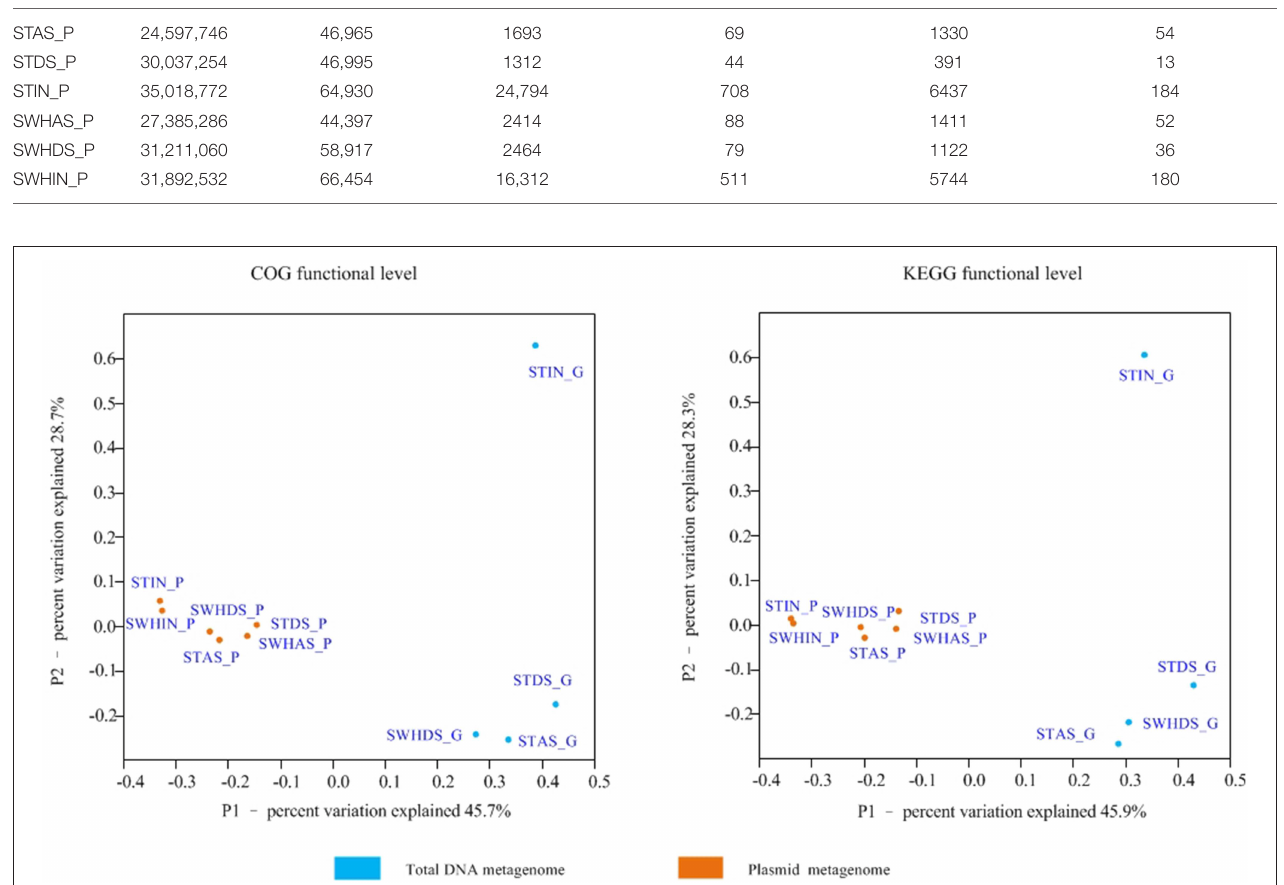
TABLE 1 | Numbers and abundance of ARGs-like and MRGs-like reads in the six plasmid metagenomes. Samples